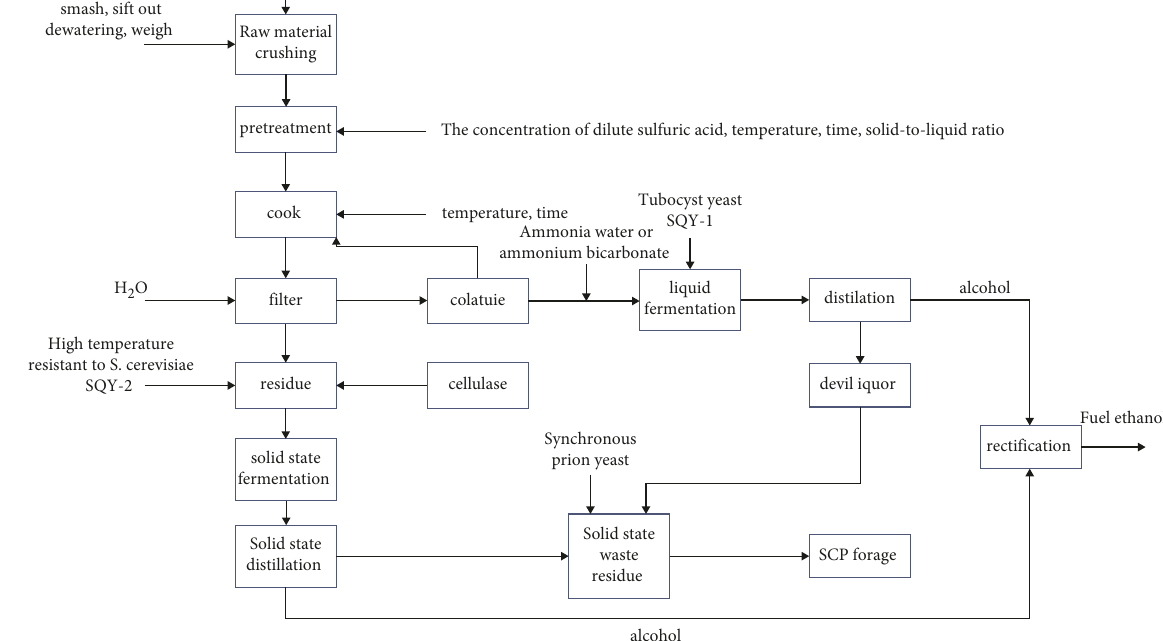
Figure 1: Flowchart of the ethanol fermentation